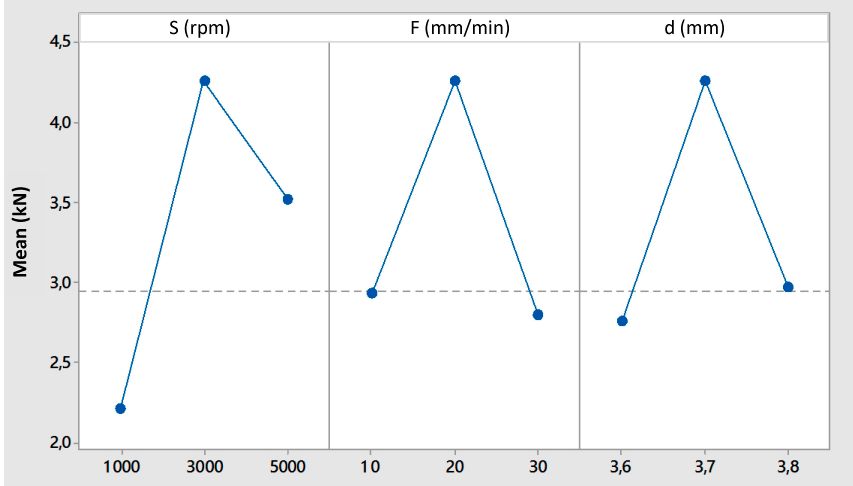
Figure 5. Main effects plot for maximum shear strength.